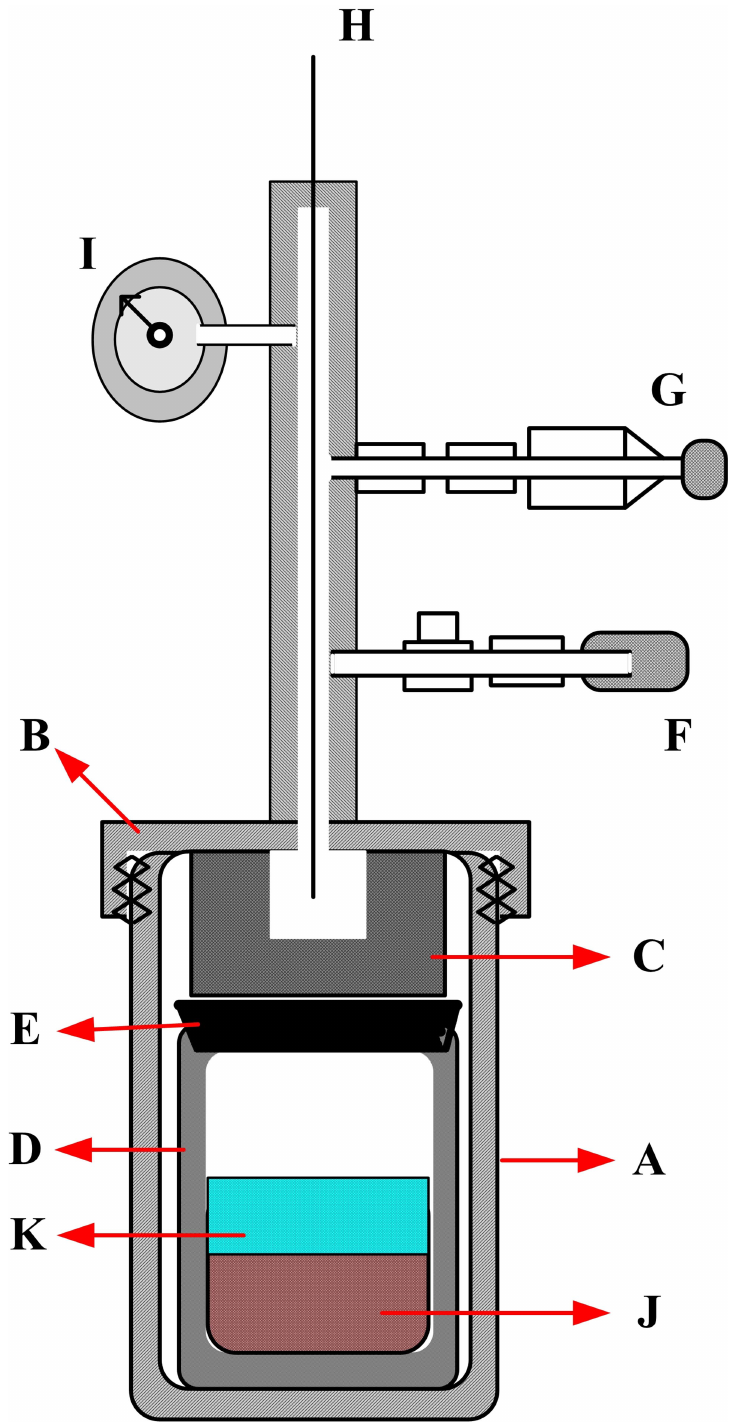
Fig 3. The structure of hydrothermal carbonization (HTC) reactor. A: Stainless steel vessel, B: pressure vessel closure, C: Fixing iron, D: Teflon cylinder, E: Teflon seal cover, F: Pressure valve, G: Relieve valve, H: Thermocouple, I: Pressure gauge, J: Biomass material, K: